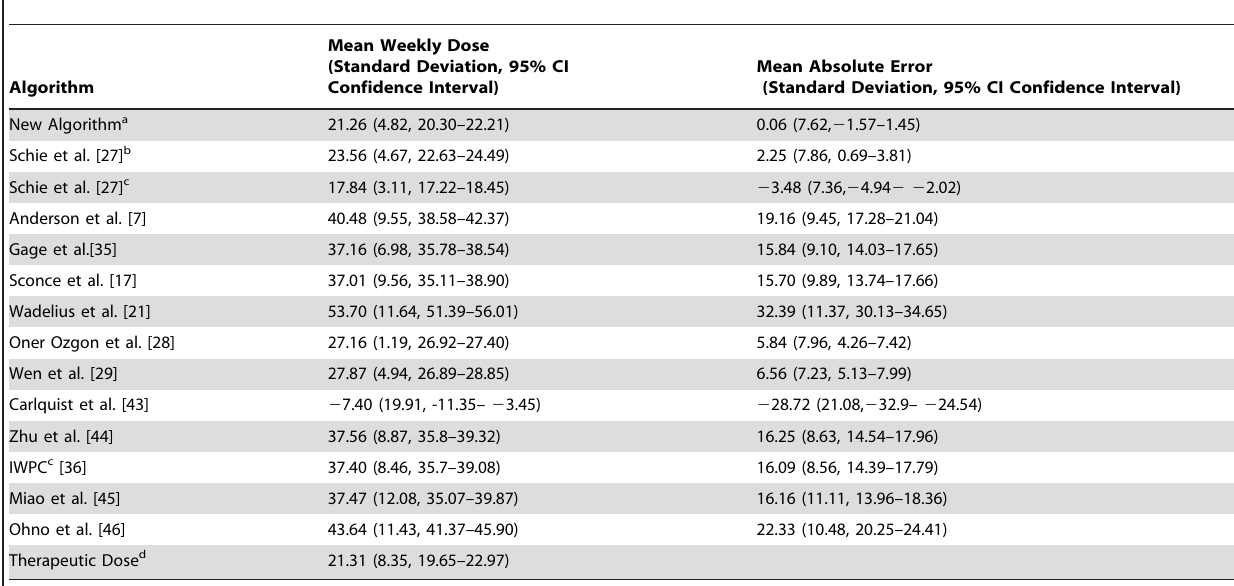
Table 4. Mean weekly doses and mean absolute errors according to different